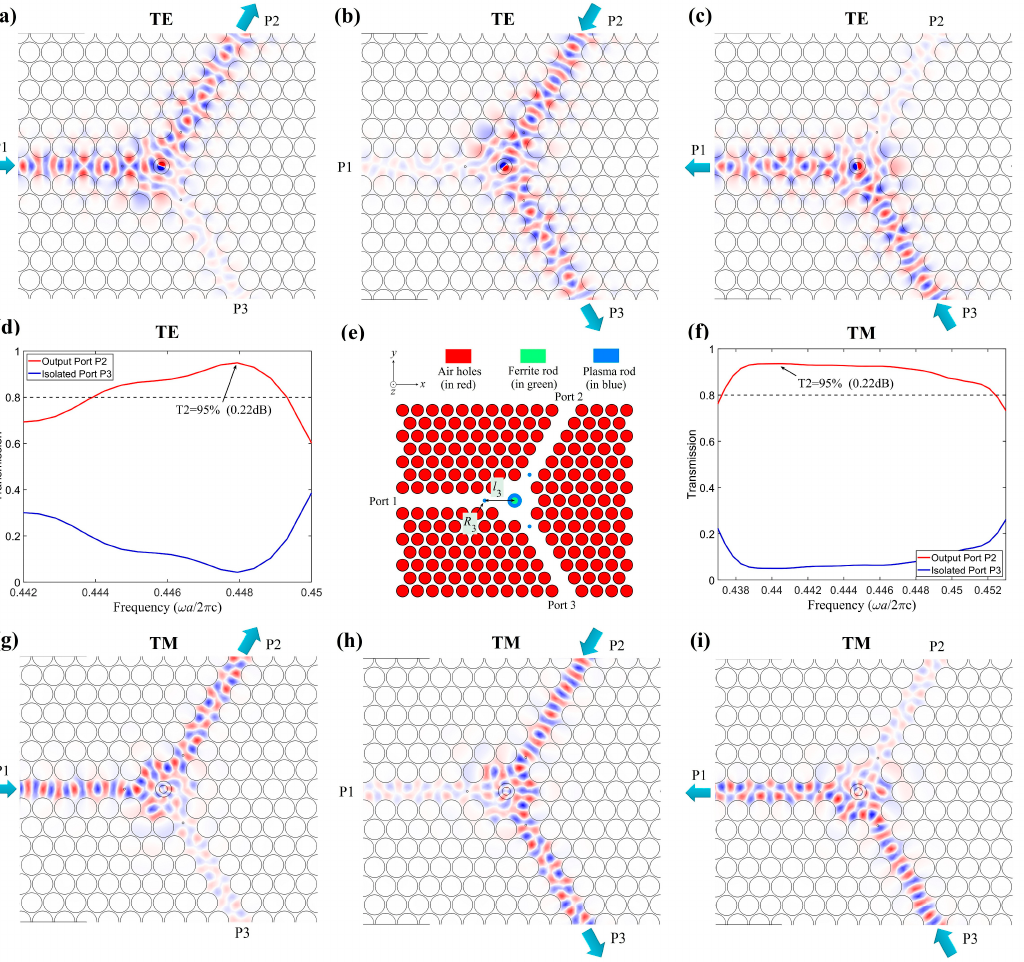
Figure 6. Performances and schematic of the optimized PIC. ( a – c ) The field distributions for TE polarization: ( a ) input from port P1, ( b ) input from port P2, and ( c ) input from port P3. ( d , f ) The frequency scans for ( d ) TE and ( f ) TM polarization. ( e ) The schematic of the optimized PIC. ( g – i ) The field distributions for TM polarization: ( g ) input from port P1, ( h ) input from port P2, and ( i ) input from port